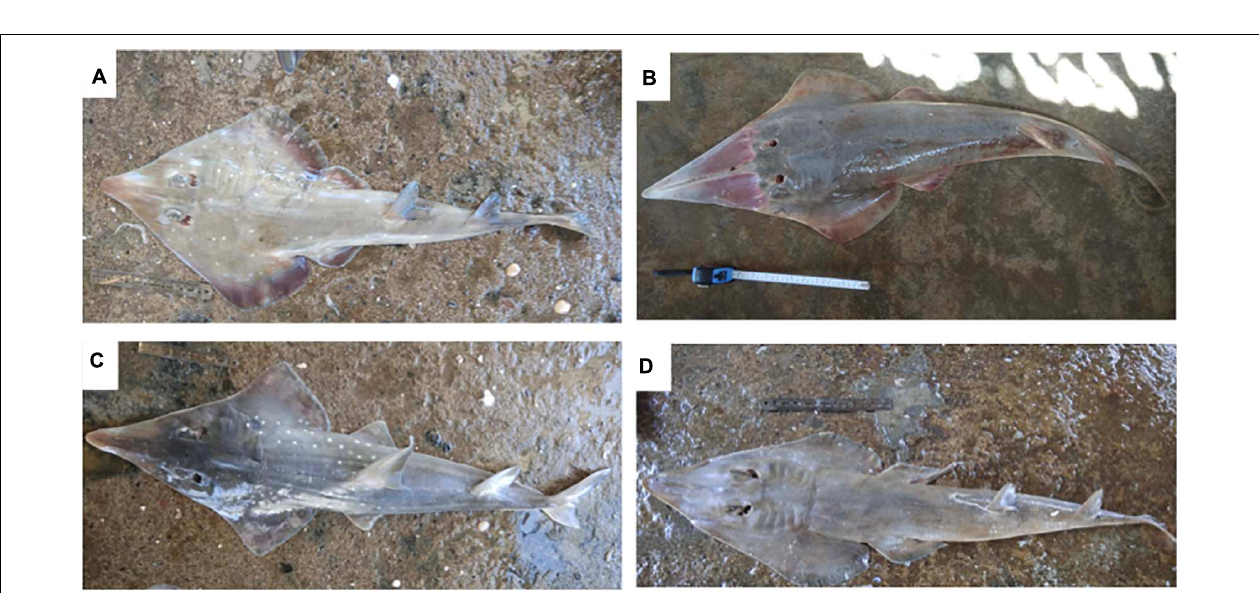
FIGURE 4 | Representative pictures of species sampled in the order Rhinopristiformes. (A) Rhinobatos annandalei (Annandale’s guitarfish), (B) Glaucostegus granulatus (Granulated guitarfish), (C) Rhynchobatus laevis (Smoothnose wedgefish), and (D) Rhinobatos punctifer (Spotted guitarfish).